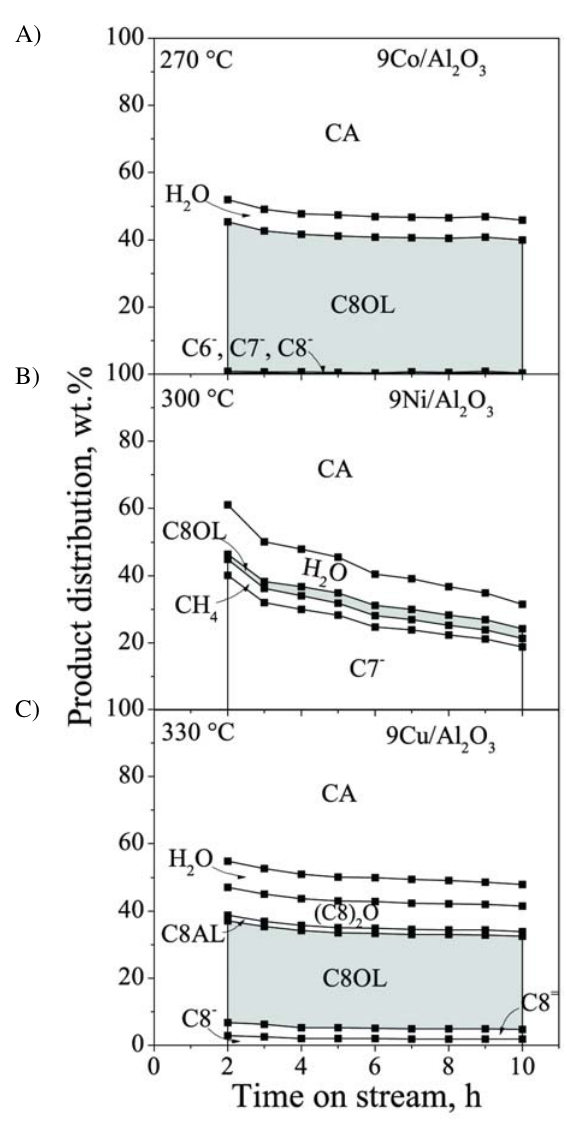
Fig. 2. Stacked area graphs of product distributions obtained from the hydroconversion of CA over catalysts (A) 9Co/Al (B) 9Ni/Al O at 300 °C [ 9 ] , and (C) 9Cu/Al 2 3 function of time on stream. The total pressure was 21 bar and the WHSV of CA was 2 h –1 . ( symbols : CA: caprylic acid; C8OL: ca- pryl alcohol; C8AL: capryl aldehyde;